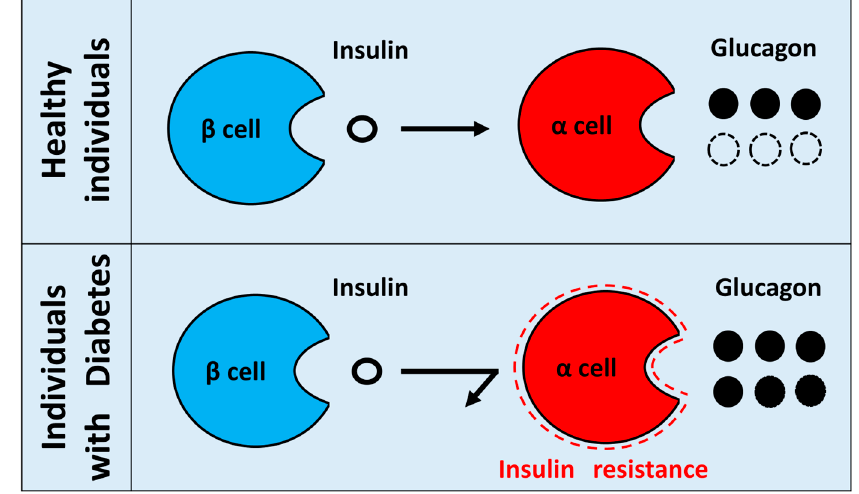
Figure 1. Hypothesis of insulin resistance regulating glucagon secretion in pancreatic α cells. In healthy individuals, insulin from pancreatic β cells regulates glucagon secretion from pancreatic α cells. By contrast, when insulin resistance exists in diabetic pancreatic α cells, insulin can no longer suppress glucagon secretion from α cells, which results in hypersecretion of glucagon. Hypothetical paradoxical glucagon hypersecretion observed in diabetes.